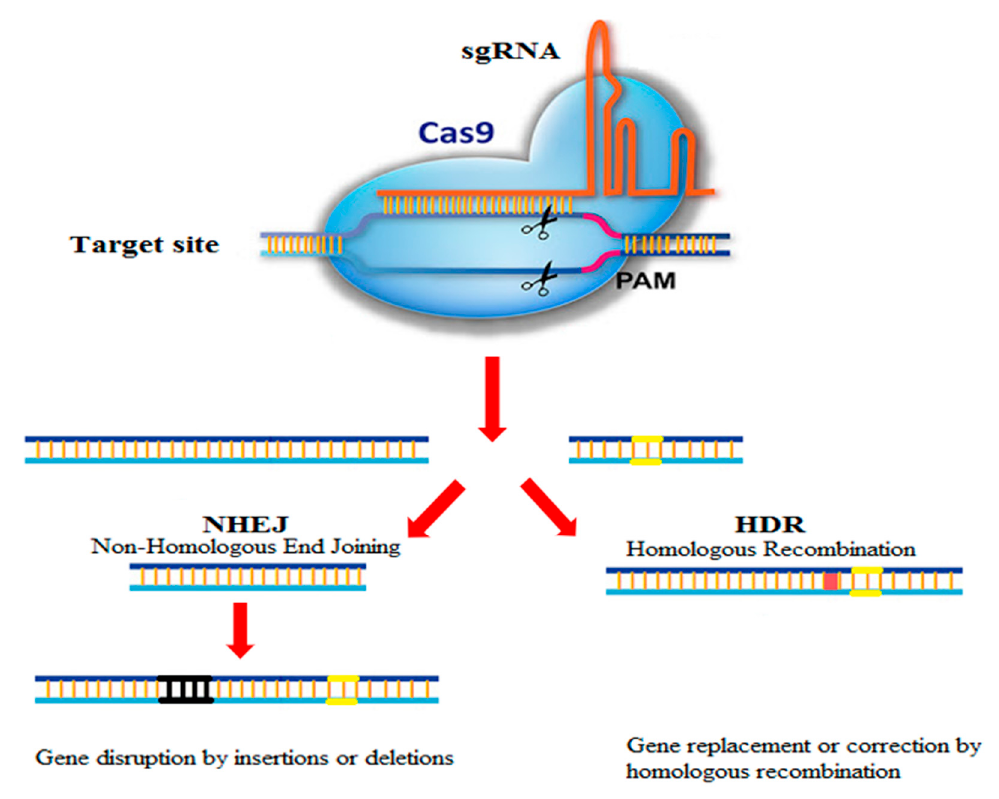
Figure 1. Schematic of CRISPR-Cas9 genome editing system.